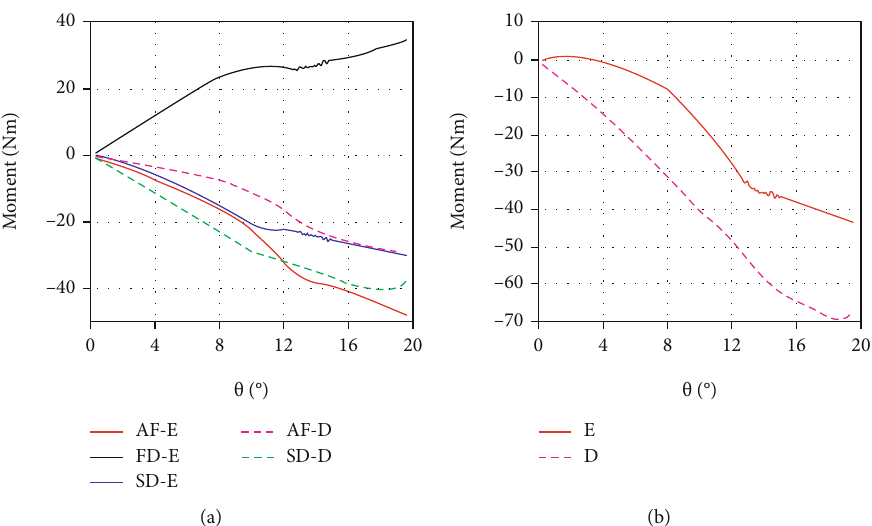
Figure 6: The yaw moment of the median fi ns in the erection and depression states under the quasi-static yaw motion ( ω = 0 : 01 rad/s): (a) the respective moment of all the median fi ns; (b) the resultant moment of all the median fi ns.